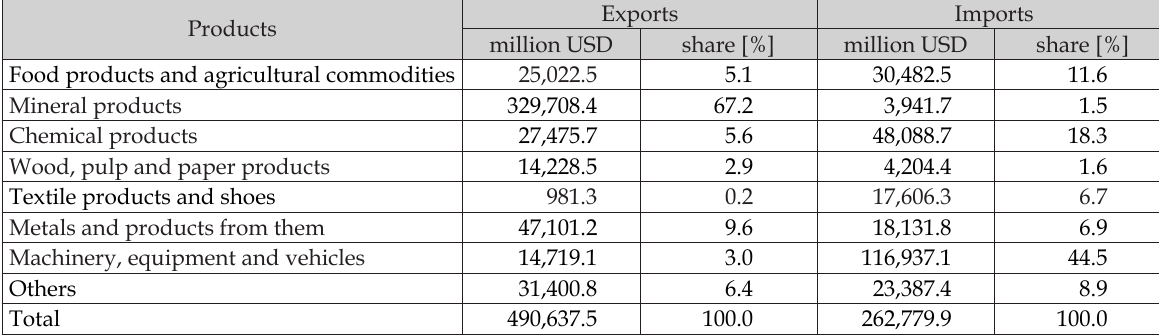
Table 3. commodity structure of foreign merchandise trade by the EAEU member states in